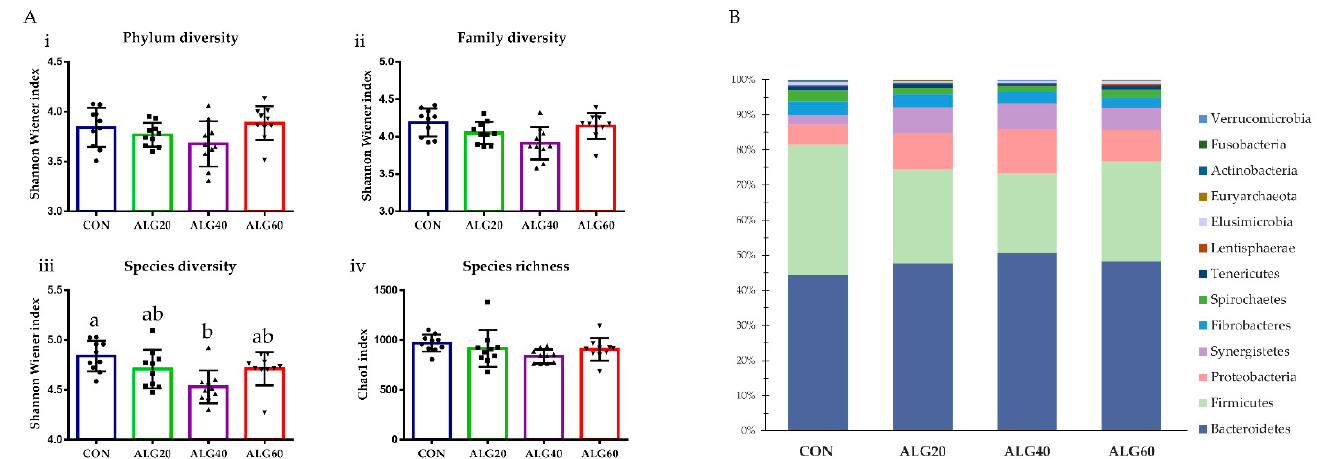
Figure 2. ( A ) Effects of supplementing with microalgae Schizochytrium spp. on (i) phylum, (ii) family, and (iii) species diversity based on the Shannon–Wiener index and (iv) Chao1 richness at the species level. Bars with different superscripts (a, b) mean dietary treatments differ significantly ( p ≤ 0.05) according to the analysis of variance (ANOVA) using a general linear model for repeated measures; post hoc analysis was performed when appropriate using the Tukey’s multiple range test. ( B ) Relative abundances of the identified phyla (unidentified clusters and no-hits were omitted) in the four dietary treatments (CON, ALG20, ALG40, and ALG60) within the two sampling times (20th and 40th days) illustrated in the cumulative bar graph. After the exclusion of the unmapped clusters and no-hit sequences, the relative abundances of the identified phyla were transformed as the percentage of the total identified taxa. The mean relative abundances of the identified phyla, unmapped bacteria, and no-hit proportions are presented in Figure S3. CON = control concentrate without microalgae ( Schizochytrium spp.); ALG20 = CON with 20 g/Kg Schizochytrium spp . ; ALG40 = CON with 40 g/Kg Schizochytrium spp . ; ALG60 = CON with 60 g/Kg Schizochytrium spp .